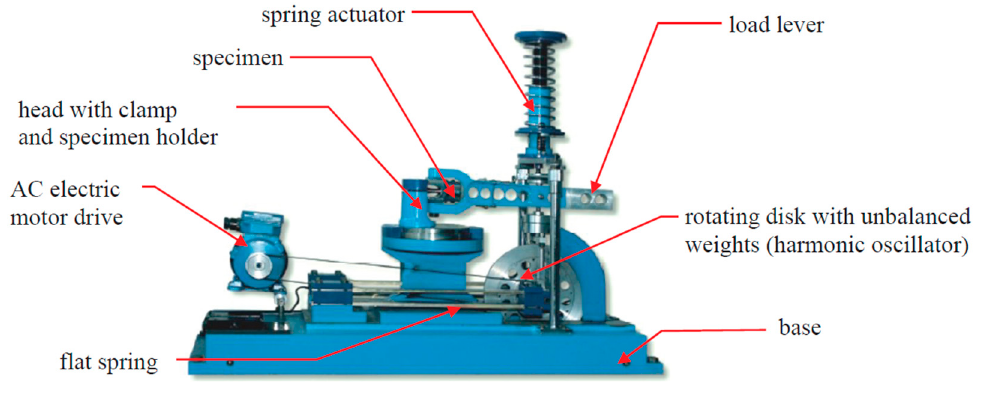
Figure 3. The overall view of the MZGS-100 test stand [30].